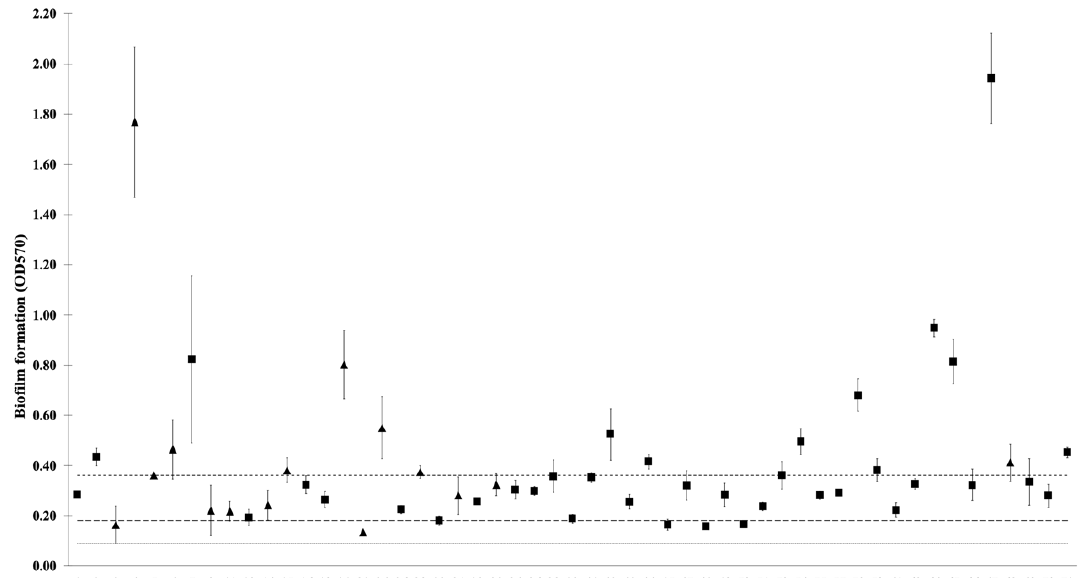
Figure 1. Biofilm formation values (OD570) of S. pseudintermedius isolates ( n = 53) obtained by quantitative biofilm production assay. The OD cut-off used to distinguish weak and moderate biofilm producers from strong biofilm producers is 0.09 (dashed line). Categories: non-biofilm producers (OD ≤ 0.09), weak biofilm producers (0.09 < OD ≤ 0.18 (dashed line)), moderate biofilm producers (0.18 < OD ≤ 0.36 (dashed line)), and strong biofilm producers (0.36 < OD). ( (cid:78) ) MRSP; ( (cid:4) ) MSSP. Table 3. Correlation between antibiotic resistant/susceptible strains and biofilm formation ability by the phenotypic method. % Biofilm Producer Antibiotics